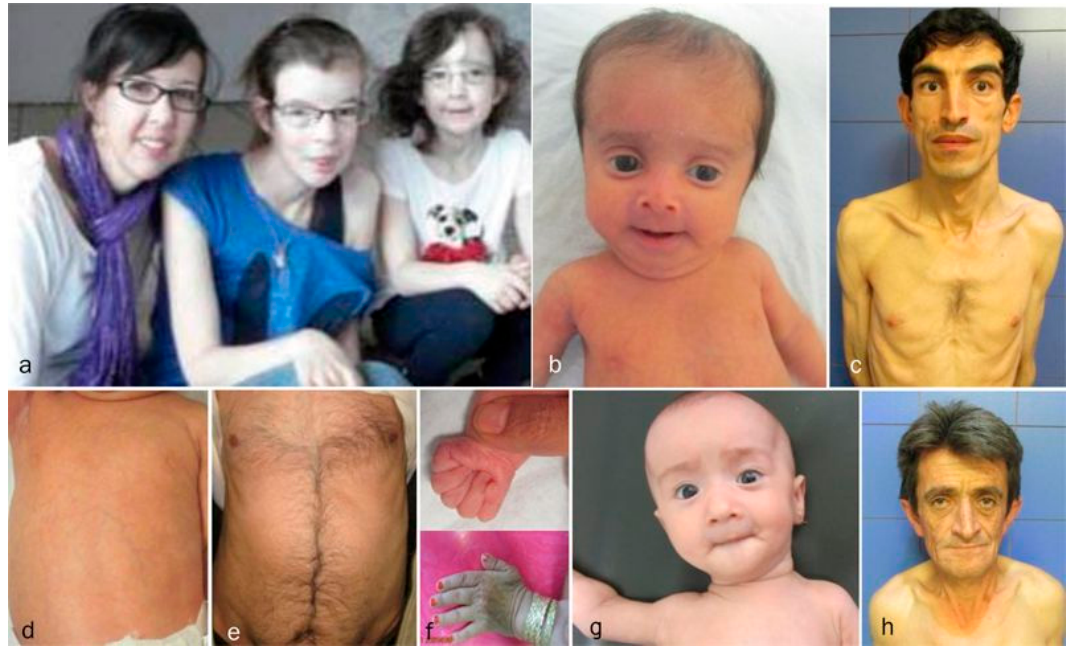
Figure 2. Comparison of aging in ARCL2A, ARCL2B, and GO. ( a ) Cutis laxa and facial dysmorphic features improves considerably in cutis laxa IIA as seen in three sisters affected with this condition; ( b ) the infant with ARCL2B has a triangular face (case 3); ( c ) The adult with ARCL2B has a long face with prognathism (case 5); ( d ) the trunk in patient with ARCL2B, the skin is translucent